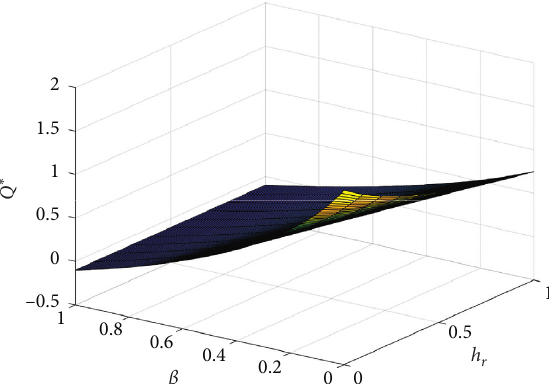
Figure 7: Effect of risk level β and unit inventory cost h optimal inventory quantity Q ∗ under RMI mode with stochastic demand in the water supply chain.